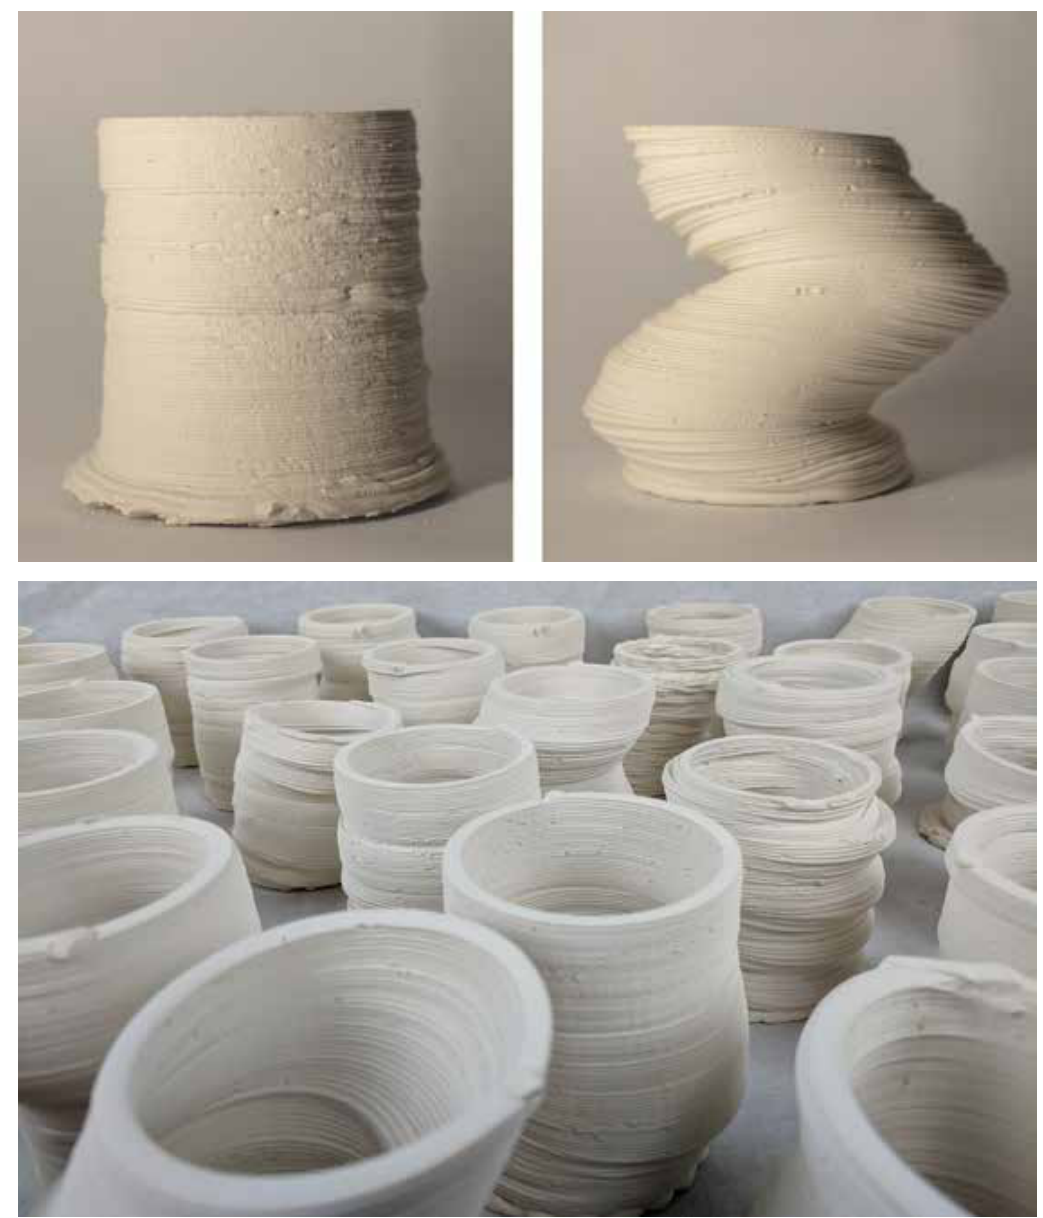
Figure 1 (top, opposite page): Custom 3D printer designed for craftsperson improvisations. Source: author. Figure 2 (bottom, opposite page): Craftsperson using manual x, y-axis controls to improvise ceramic form. Source: author.